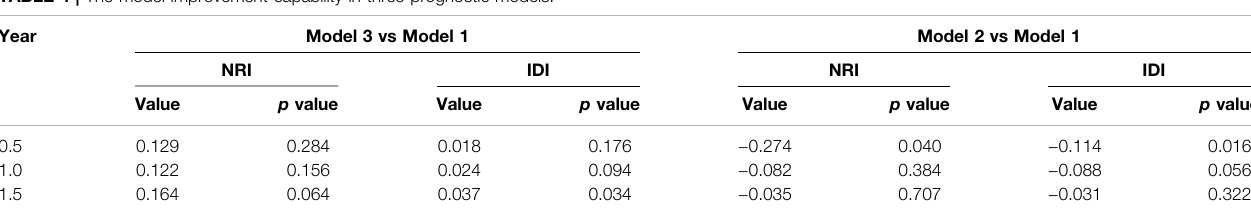
TABLE 4 | The model improvement capability in three prognostic